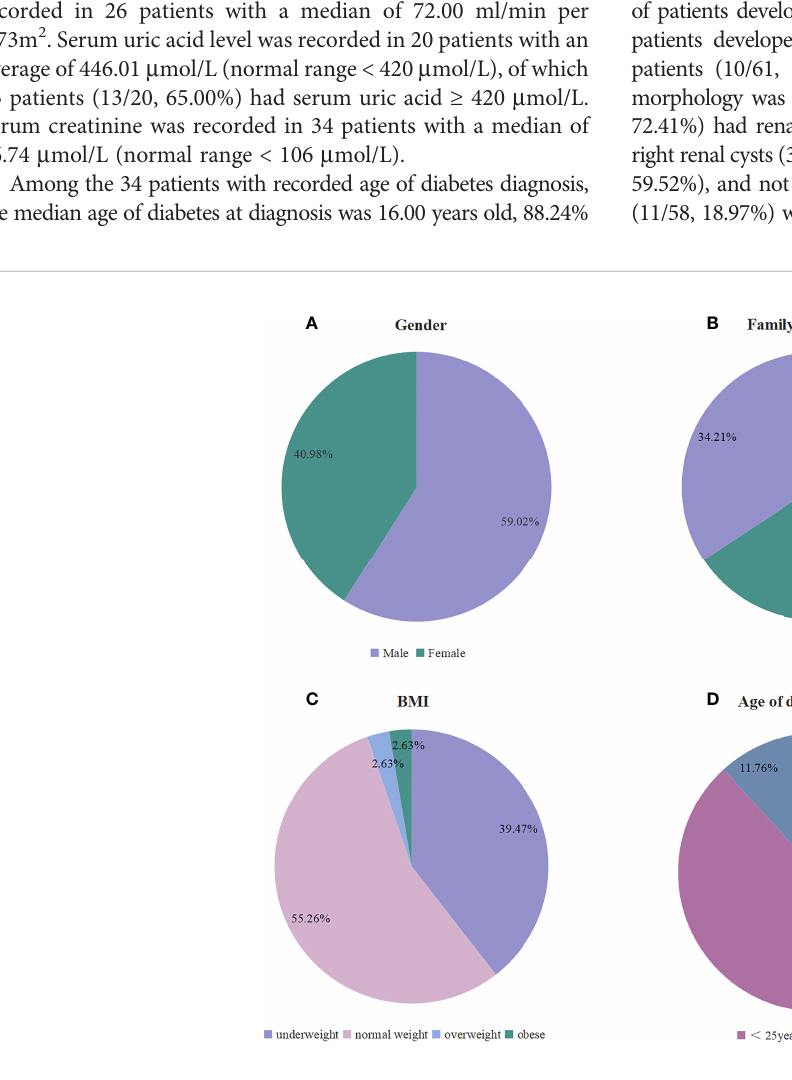
FIGURE 2 | Clinical characteristics of patients with MODY5. (A – D) The proportion of several clinical characteristics in enrolled patients: (A) gender (N: 61), (B) family history of diabetes (N: 38), (C) BMI (N: 39), and (D) Age of diabetes diagnosis (N: 34).